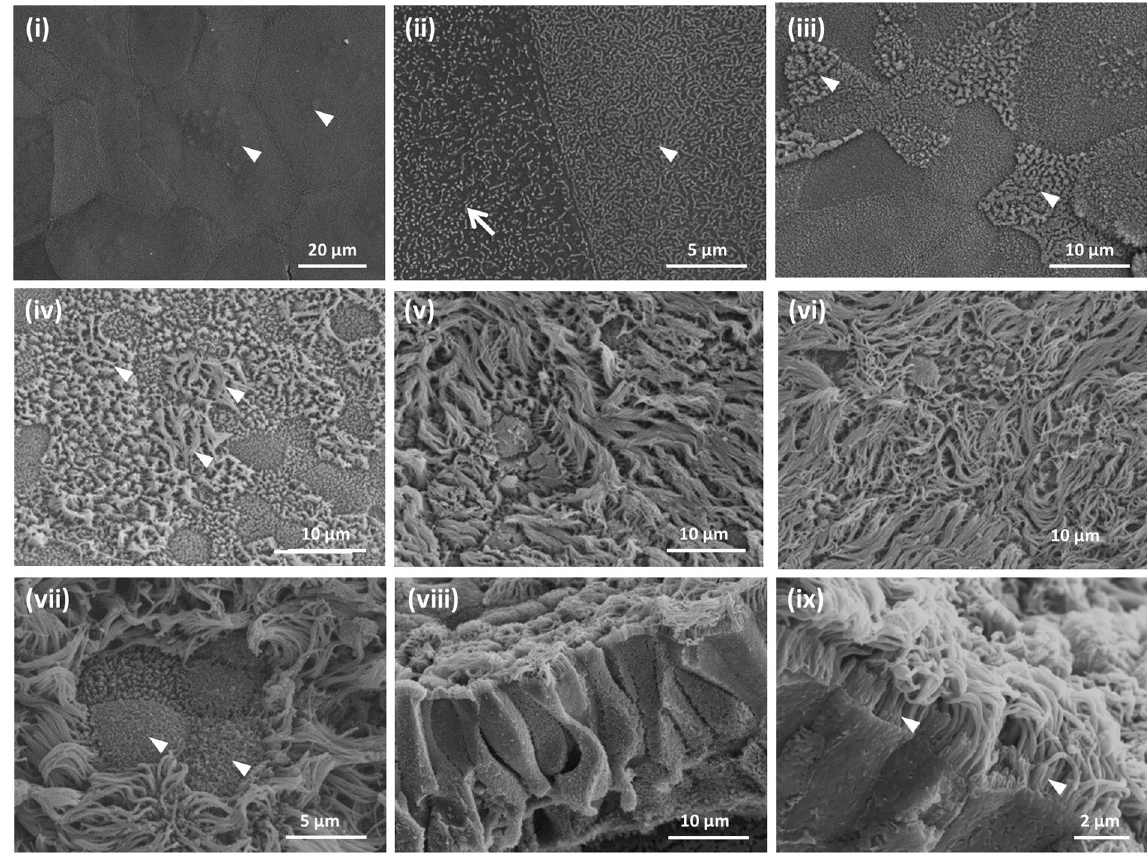
Figure 6. Scanning electron microscopic assessment of ultrastructural changes in BBEC cultures over time. Bronchial epithelial cell cultures were grown until 42 days post-ALI and samples fixed at three day intervals and processed for SEM (see also Fig. S6). Representative micrographs show (i) the undifferentiated, flattened apical surface at day 0 post-ALI with extruding nuclei (arrowheads); (ii) microvilli (arrow) and microplicae (arrowhead) on undifferentiated cells at day 0 post-ALI; (iii) longer microvilli (arrowheads) on day 3 post ALI cells undergoing differentiation; (iv) early stages of cilia formation (arrowheads) on day 6 post-ALI cells undergoing differentiation; (v) numerous well-formed cilia on day 12 post ALI cells; (vi) maximum ciliation on day 24 post-ALI cells; (vii) goblet cells (arrowheads) present in day 21 post-ALI cultures; (viii) section of day 18 post-ALI epithelium showing pseudostratified structure; and (ix) microvilli (arrowheads) at base of cilia associated with day 36 post-ALI